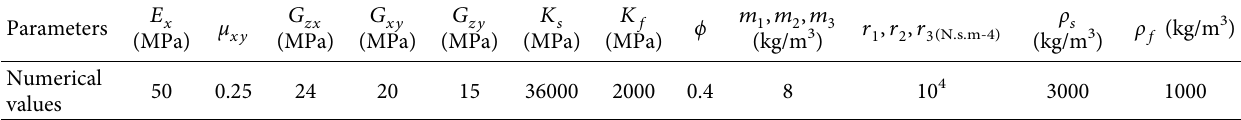
Table 1: Soil parameters.